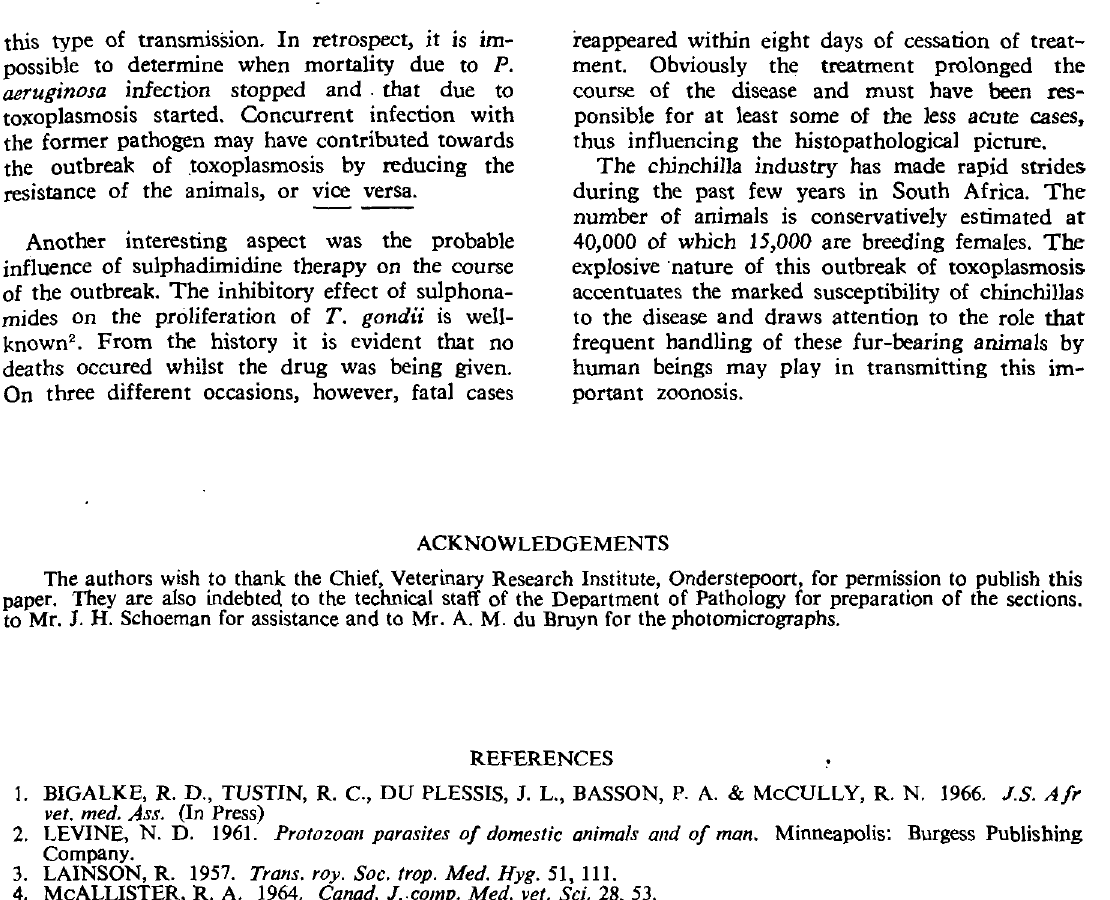
A. Medium-sized necrotic focus surrounded by plasma cells in liver. H & E, X2OO. B. Extensive focal necrosis of liver, with marked reticu lo-endotheliosis in sinusoids between foci. H & E. X75. C. Hyperplasia of lymphoid follicles in spleen. H & E, X75. D. Focal necrosis with round cell infiltration in myo cardium. H & E, Xloo. E. Toxoplasma cysts (1), glioma (arrow) and peri vascular infiltration by plasma cells (upper right) in brain. H & E, X200. F. Higher magnification of focal gliosis in E. H & E. X480. G. Several Toxoplasma cysts in brain unaccompanied by host reaction. H & E, X480. H. Toxoplasma cyst in adrenal medulla. H & E.